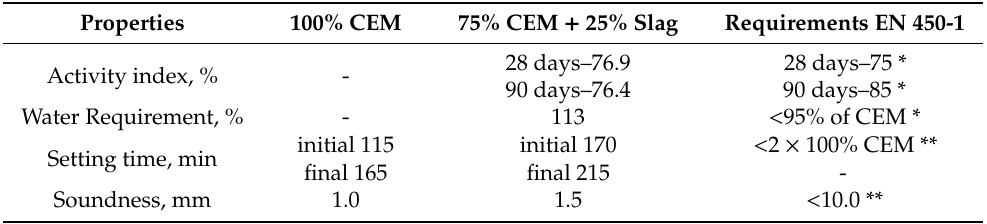
Table 8. Test results of physical and mechanical characteristics of slag.